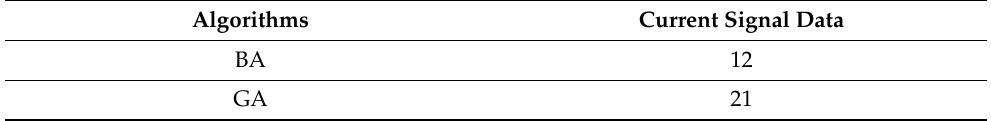
Table 1. Number of selected